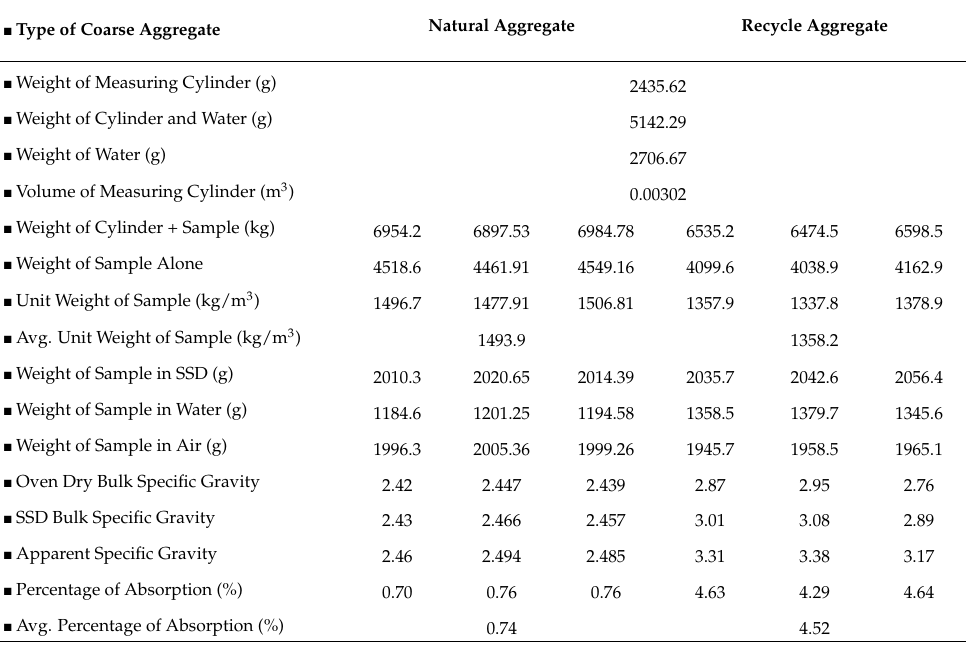
Table 3. Unit weight and water absorption characteristics of natural and recycled aggregates.